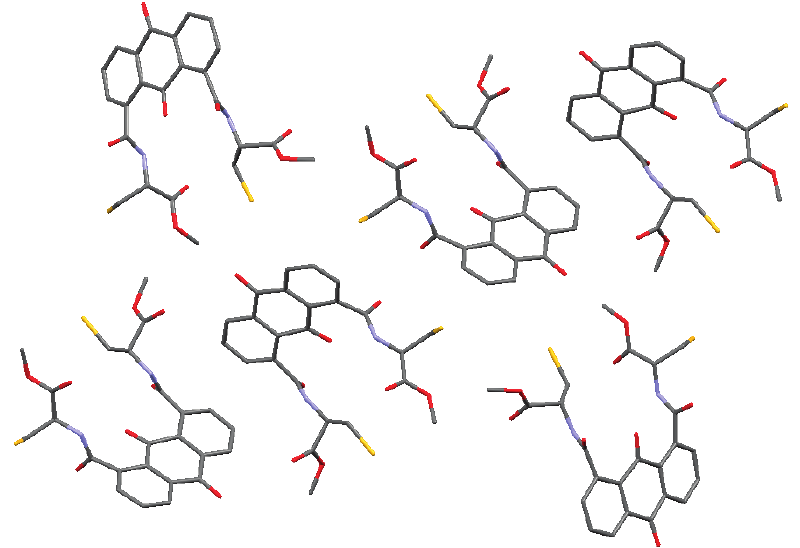
Figure 2. Packing diagram of the unit cell along the a axis. Hydrogen atoms are omitted for clarity.